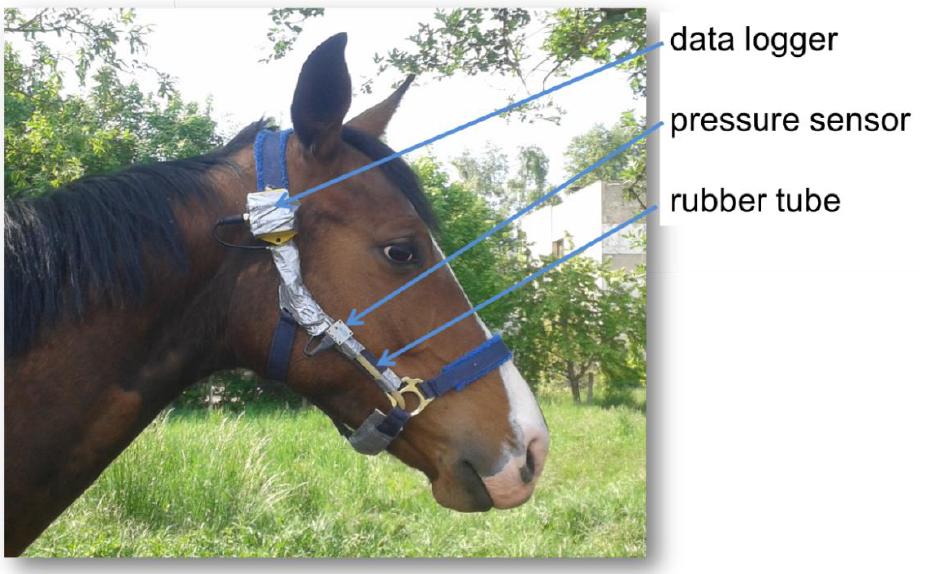
Figure 1. Modified halter equipped with measuring instruments for the detection of chewing pa- rameters.